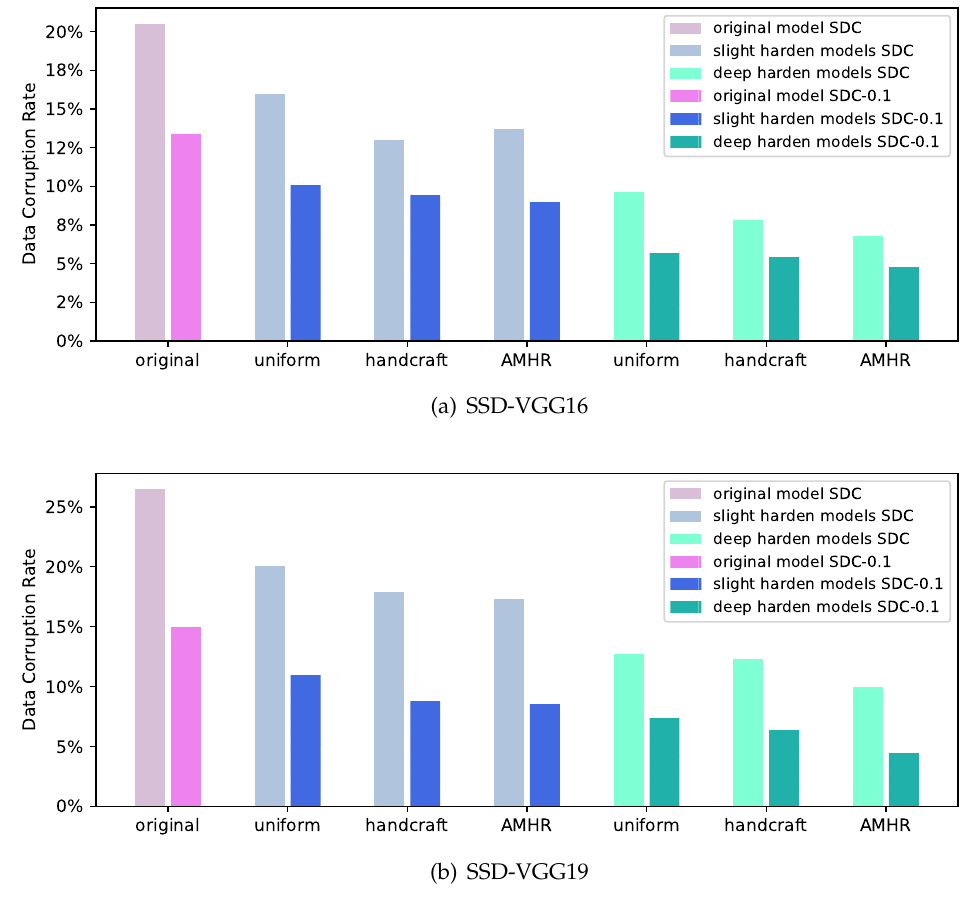
Figure 10. Fault tolerance analysis for detectors with different hardening methods: (a) shows SDC and SDC-0.1 rates for SSD-VGG16 hardening models; (b) shows SDC and SDC-0.1 rates for SSD-VGG19 hardening models.